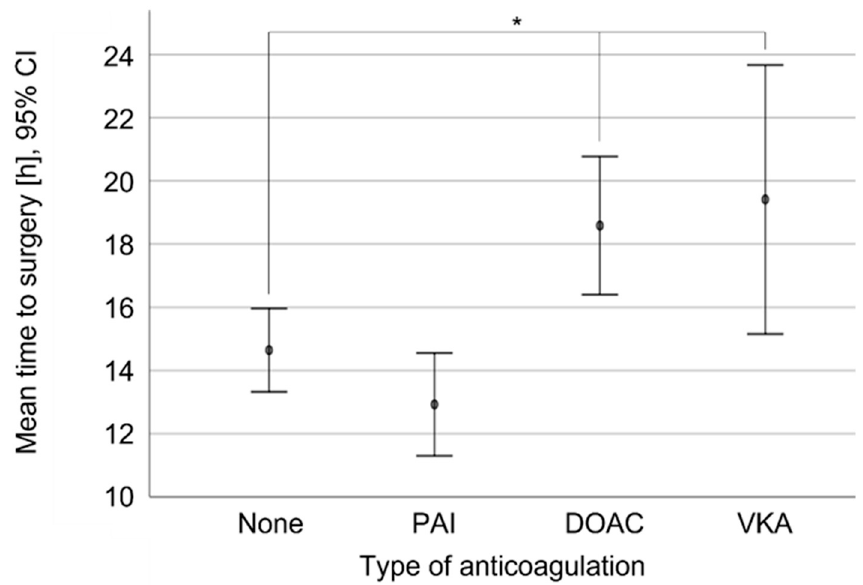
Figure 2. Mean time to surgery [h] depending on anticoagulative medication. PAI: Platelet aggre- gation inhibitors including acetylsalicylic acid; DOAC: Direct oral anticoagulants; VKA: Vitamin-K- antagonist Warfarin; p < 0.05 *.